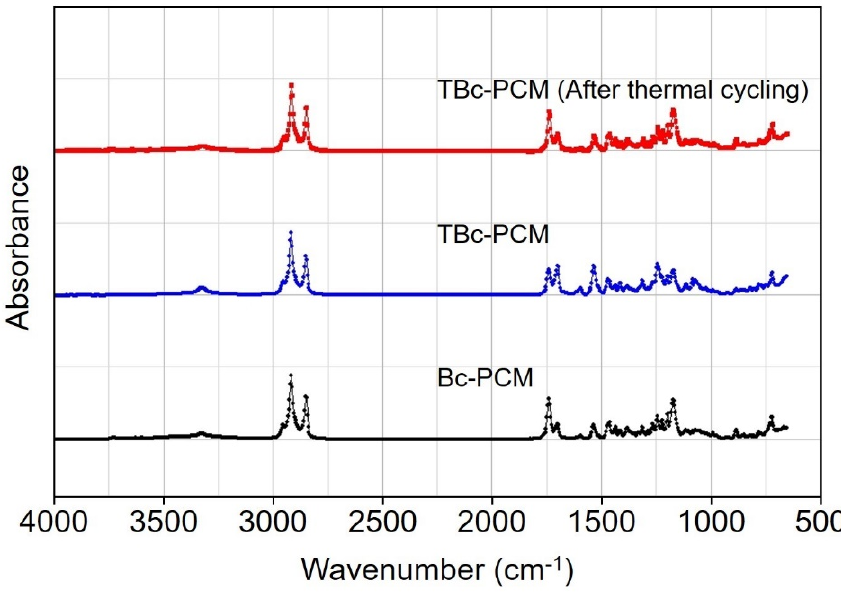
Figure 2. FTIR analysis of Bc-PCM and TBc-PCM.